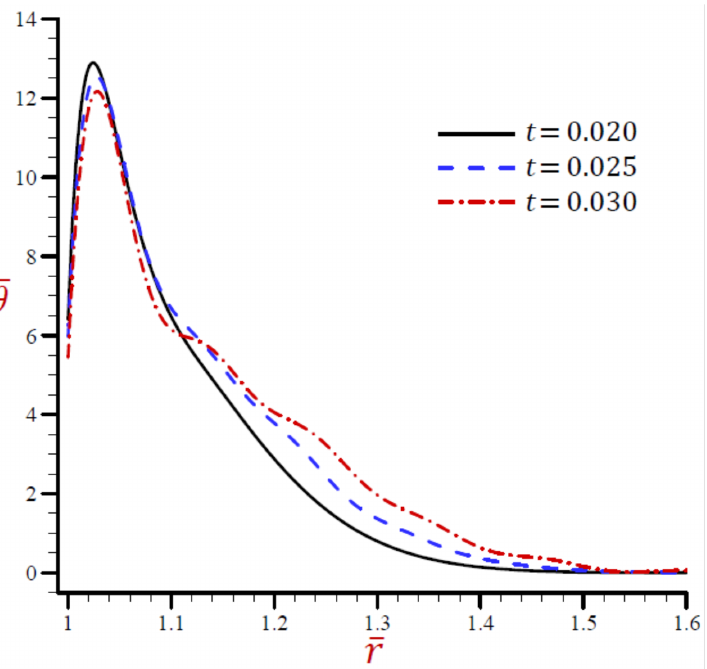
Figure 19. Effect of t on temperature θ across the radial direction of the cylindrical cavity utilizing the RDPL